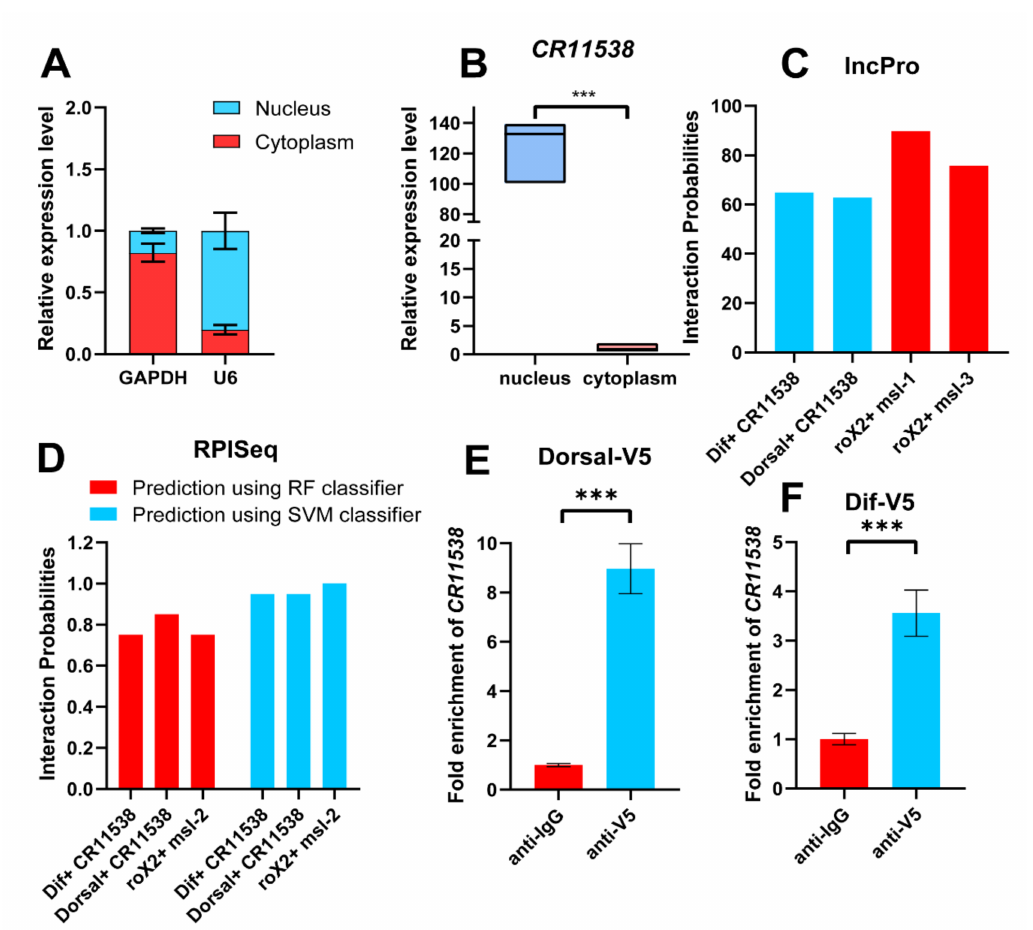
Figure 4. LncRNA-CR11538 interacts with Dif/Dorsal. ( A ) U6 and GAPDH are marker genes used to confirm partitioning between nucleus and cytoplasm. ( B ) LncRNA-CR11538 expression in nucleus and cytoplasm detected by RT-qPCR. Predicted scores for interaction potential of lncRNA-CR11538 with Dif or Dorsal via IncPro ( C ) and RPISeq ( D ) databases. LncRNA- CR11538 fold enrichment measured by RIP-qPCR using anti-V5 antibody to immunoprecipitate overexpressed Dorsal-V5 ( E ) and Dif-V5 ( F ) in S2 cells. For all tests, p value < 0.05 was considered as statistically significant. *** p < 0.001 vs. the control